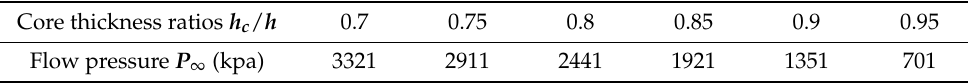
Table 8. Flow pressures with core thickness ration